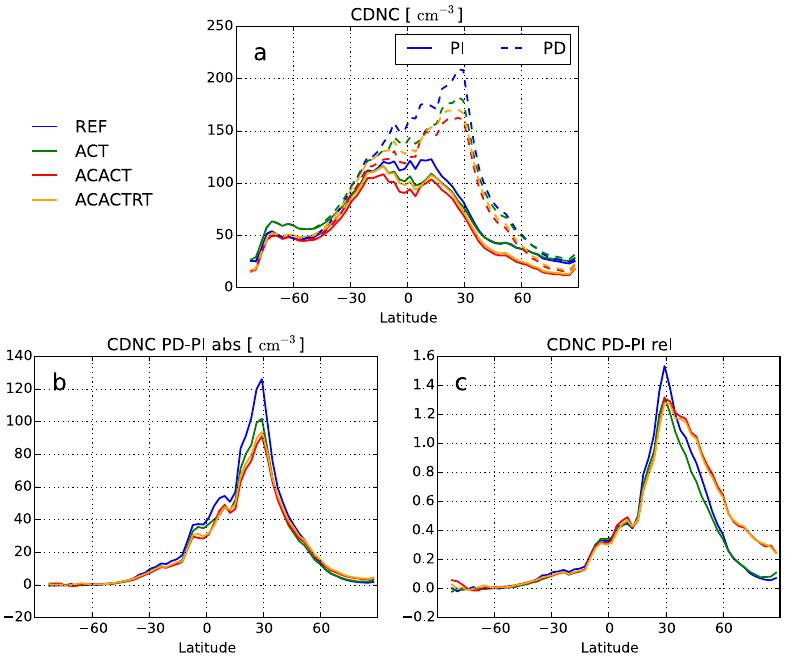
Figure 4. (a) CDNC at the 890hPa pressure level for PI and PD conditions in cm − 3 , and (b) the absolute and (c) relative anthropogenic changes in